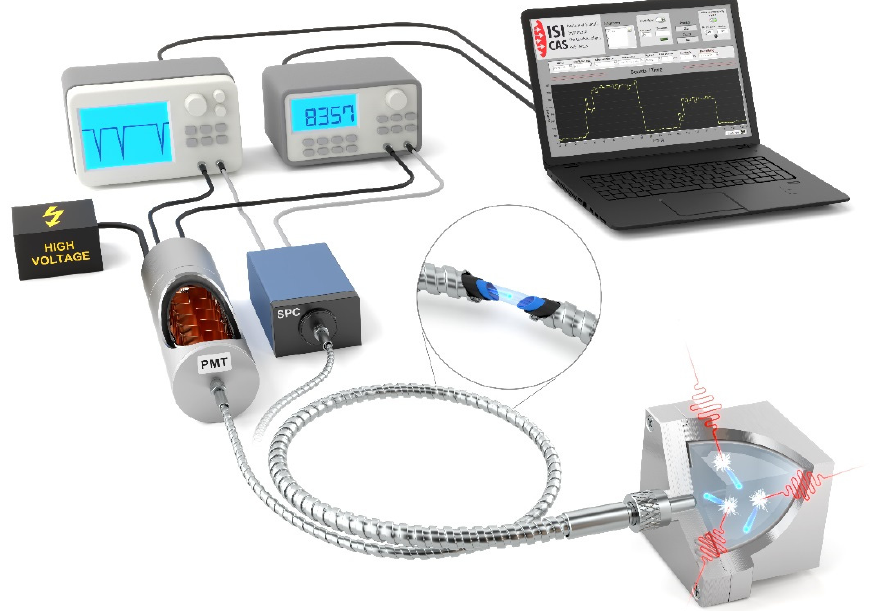
Figure 1. Schematic of the measuring system for ionising radiation measurement. The measuring system contains two variable detection units—SPC and PMT, multimode optical fibre and scintillation crystal hidden in an aluminium box.